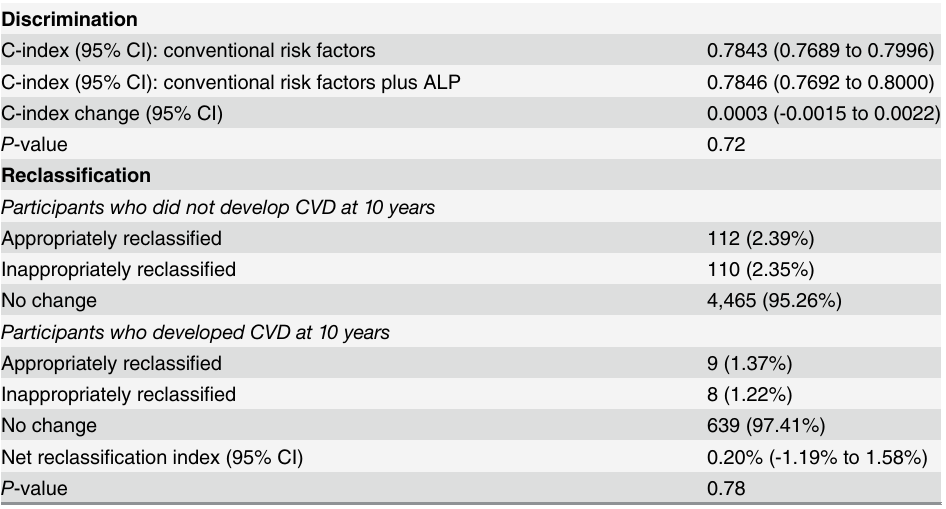
Table 4. Risk discrimination and reclassification upon addition of ALP to the Framingham CVD risk prediction model containing conventional risk factors. Discrimination